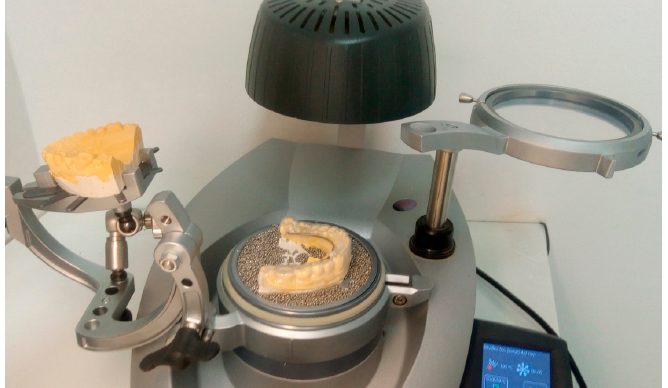
Figure 4. Preparation of the second lamination with 4 mm EVA foil.